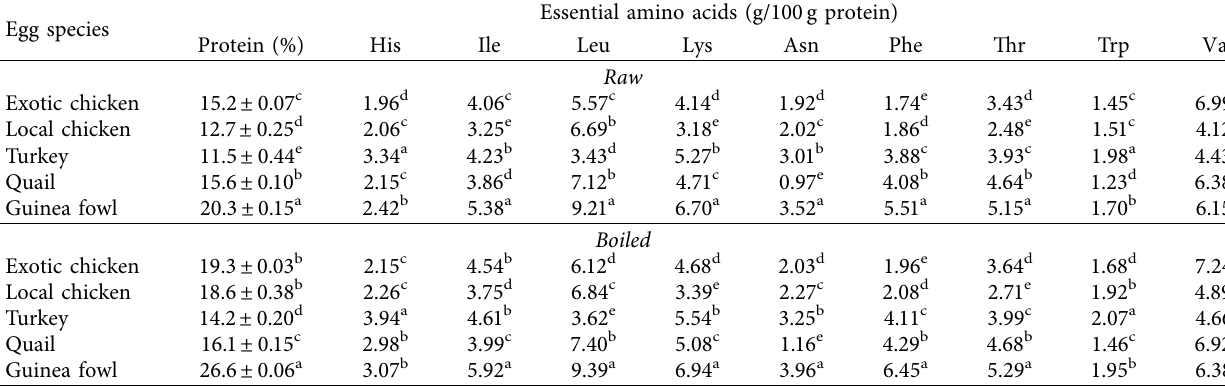
Table 1: Essential amino acid composition of raw and boiled egg varieties.